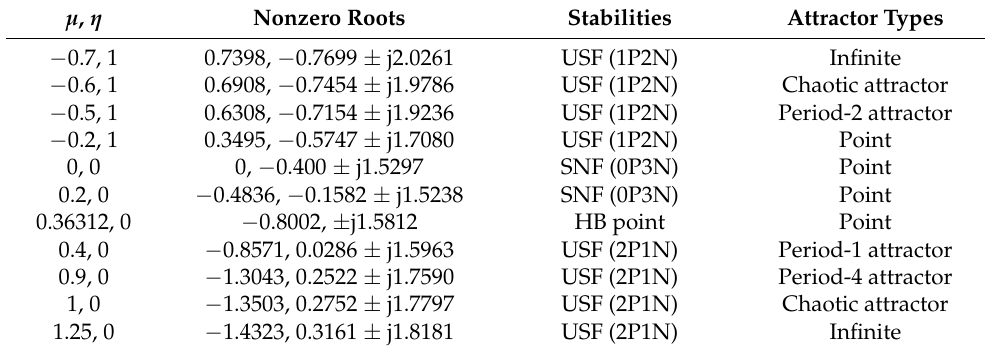
Table 1. For different values of µ and η , the nonzero roots, stabilities, and attractor types. µ , η Nonzero Roots Stabilities Attractor Types − 0.7, 1 0.7398, − 0.7699 ± j2.0261 USF (1P2N) Infinite − 0.6, 1 0.6908, − 0.7454 ± j1.9786 USF (1P2N) Chaotic attractor − 0.5, 1 0.6308, − 0.7154 ± j1.9236 USF (1P2N) Period-2 attractor − 0.2, 1 0.3495, − 0.5747 ± j1.7080 USF (1P2N) Point 0, 0 0, − 0.400 ± j1.5297 SNF (0P3N) Point 0.2, 0 − 0.4836, − 0.1582 ± j1.5238 SNF (0P3N) Point 0.36312, 0 − 0.8002, ± j1.5812 HB point Point 0.4, 0 − 0.8571, 0.0286 ± j1.5963 USF (2P1N) Period-1 attractor 0.9, 0 − 1.3043, 0.2522 ± j1.7590 USF (2P1N) Period-4 attractor 1, 0 − 1.3503, 0.2752 ± j1.7797 USF (2P1N) Chaotic attractor 1.25, 0 − 1.4323, 0.3161 ± j1.8181 USF (2P1N)